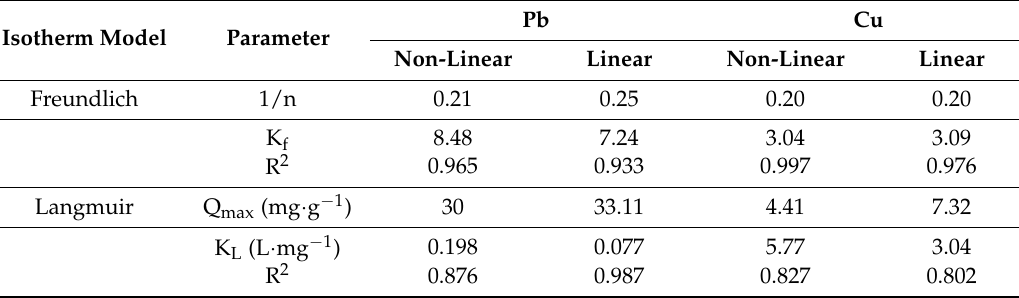
Table 2. Isotherm parameters of Freundlich and Langmuir models.